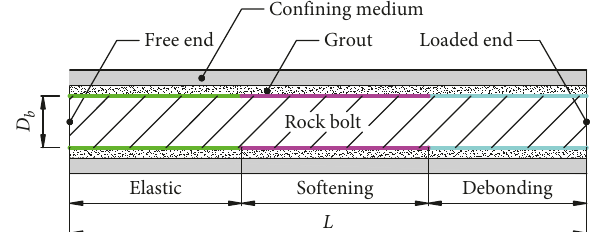
Figure 5: The full bolt/grout interface is composed of the elastic section, softening section, and debonding section in the elastic- softening-debonding